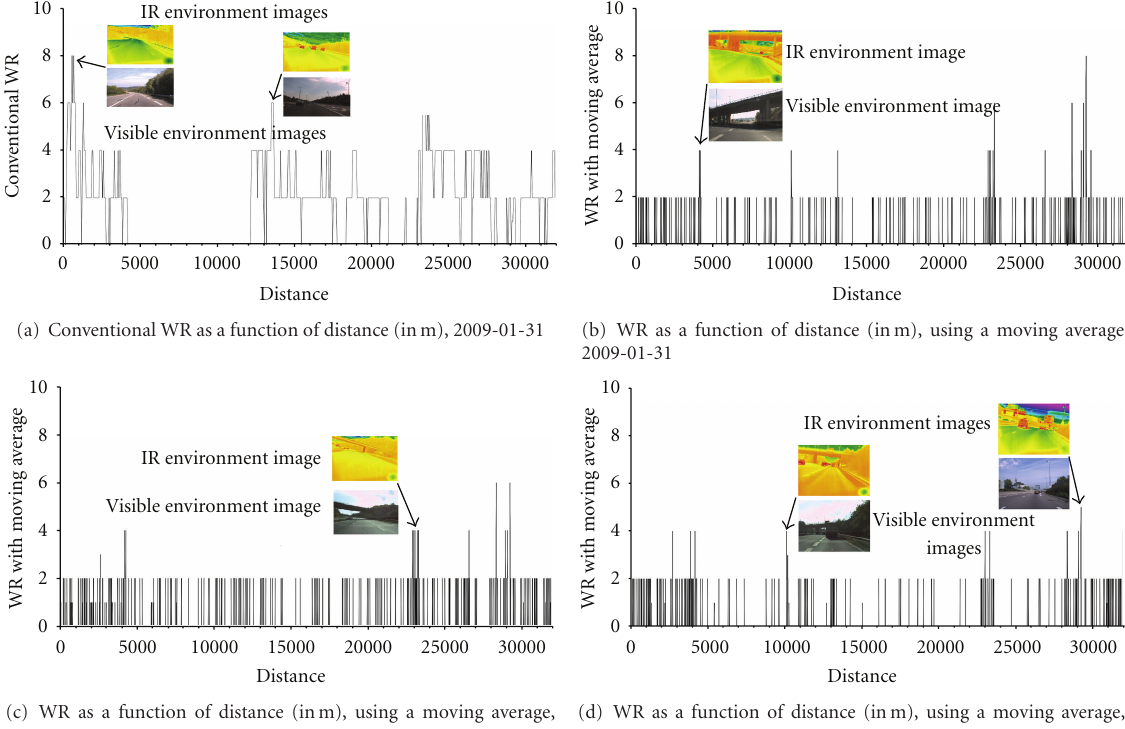
Figure 5: Winter risk indexes of the same road stretch at di ff erent seasons; IR and visible images corresponding to road points with highest WR values are